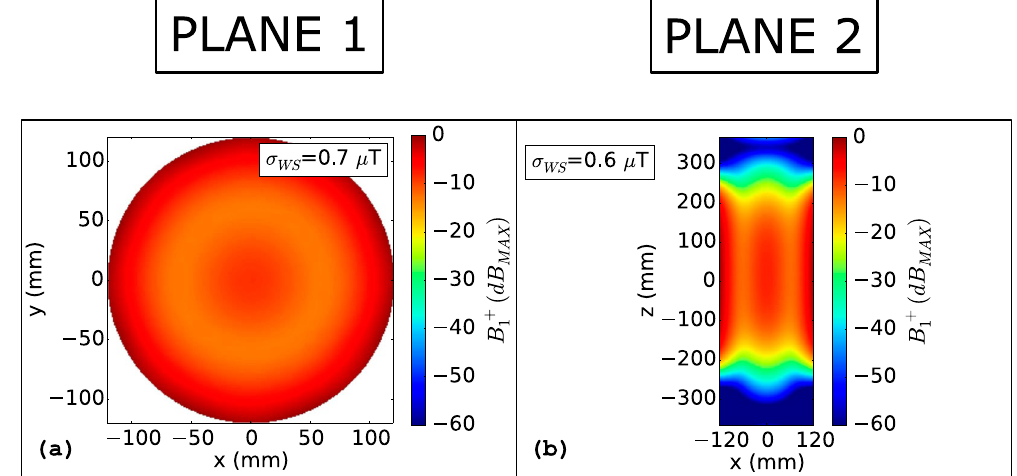
Figure 3. B 1 + ( dB MAX ): Unperturbed condition. B 1 + ( dB MAX ) evaluated for the ideal case without any object inside the coil. The figure refers to the transverse symmetry plane of the phantom ( a ) and to the longitudinal one ( b ). σ WS represents the standard deviation computed on the whole slice.